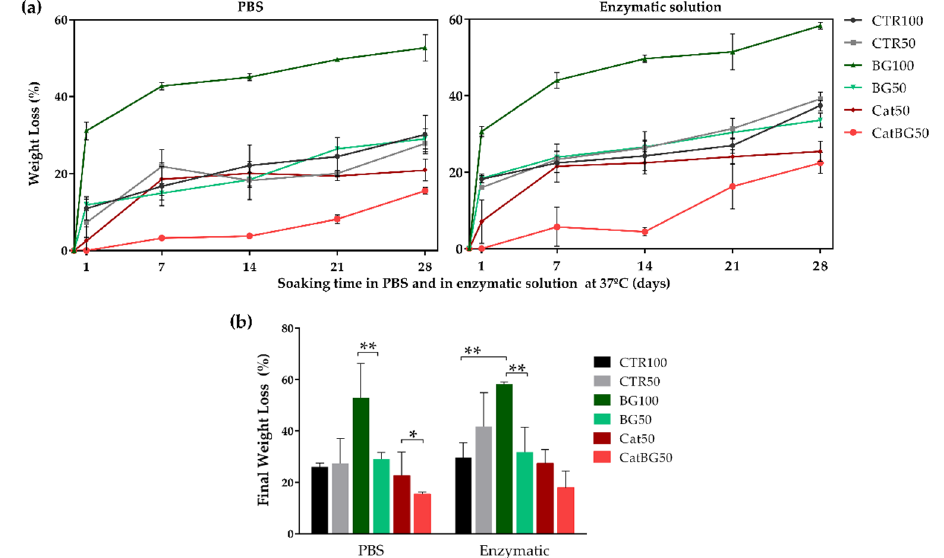
Figure A4. Degradation behavior of the LbL films upon immersion in PBS and in PBS enzymatic solution for 28 days at 37 °C. ( a ) Weight loss percentage as a function of time; ( b ) final weight loss percentage. Significant differences were found for p < 0.05 (*) and p < 0.01 (**).